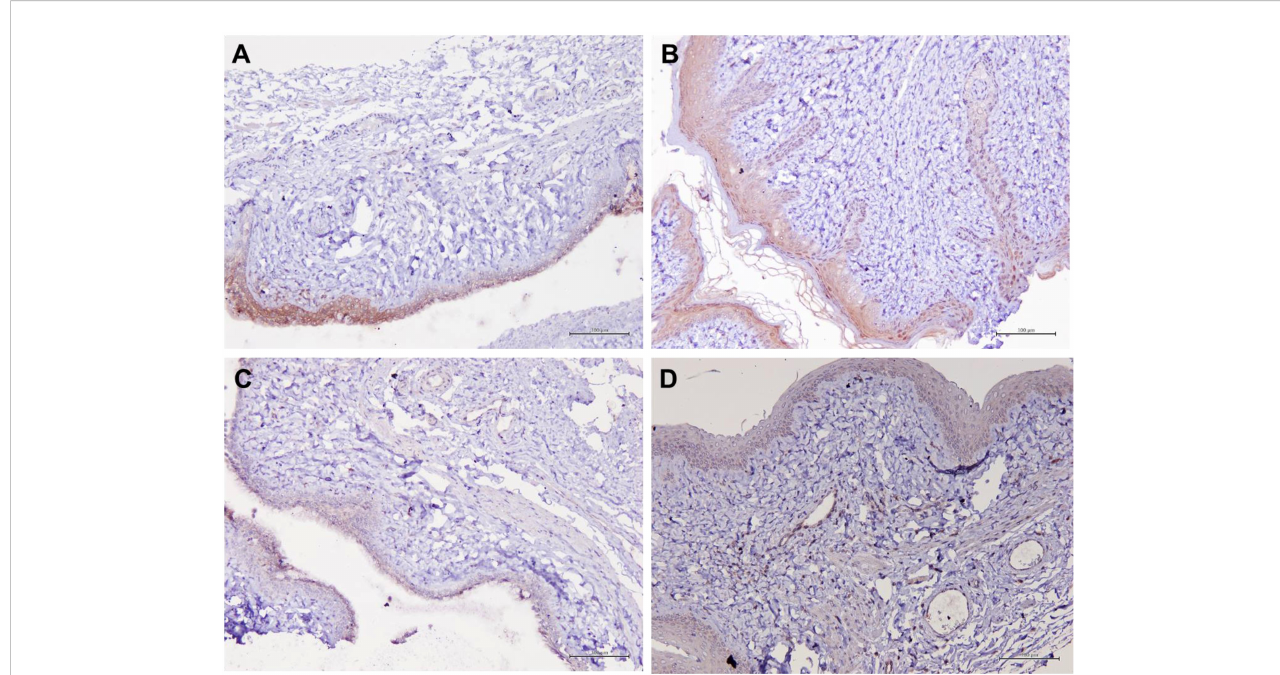
FIGURE 5 Structure of the rat vaginal epithelium and Aqp5 protein localization in the rat vaginal tissue following a two-week administration of Gelam honey at 0.2 g Gelam honey/kg bw/day doses. (A) Gelam honey and bilateral oophorectomized group (Gelam honey+Ovx), (B) Estrogen replacement therapy and bilateral oophorectomized group (ERT+Ovx), (C) Bilateral oophorectomized group (Ovx) and (D) Sham group (SC). The tissues were stained with DAB/ HRP stain for protein localization (in brown) and counterstained with H&E for nuclear staining. All measurement bars are equivalent to 100